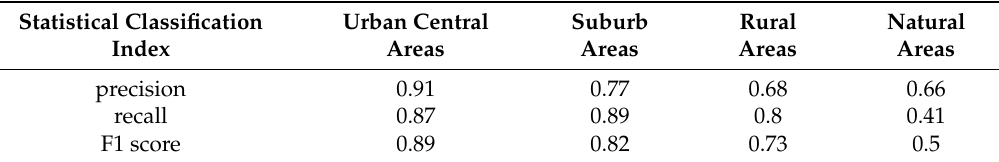
Table 2. Accuracy assessment on the extraction results.